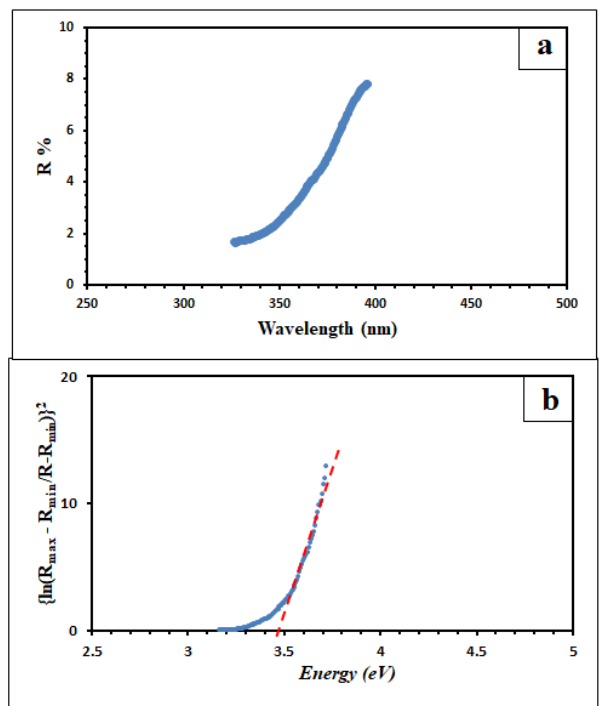
Figure 7: (a) Reflection spectra of TiO nanorods by hydrothermal method and (b) energy bandgap. 2 It is obvious from equation 7 that ln[(Rmax – Rmin)/(R – Rmin)] and, where Rmax and Rmin are the greatest and minimum reflectance in reflection spectra, respectively, and R is the reflectance for any intermediate energy photons